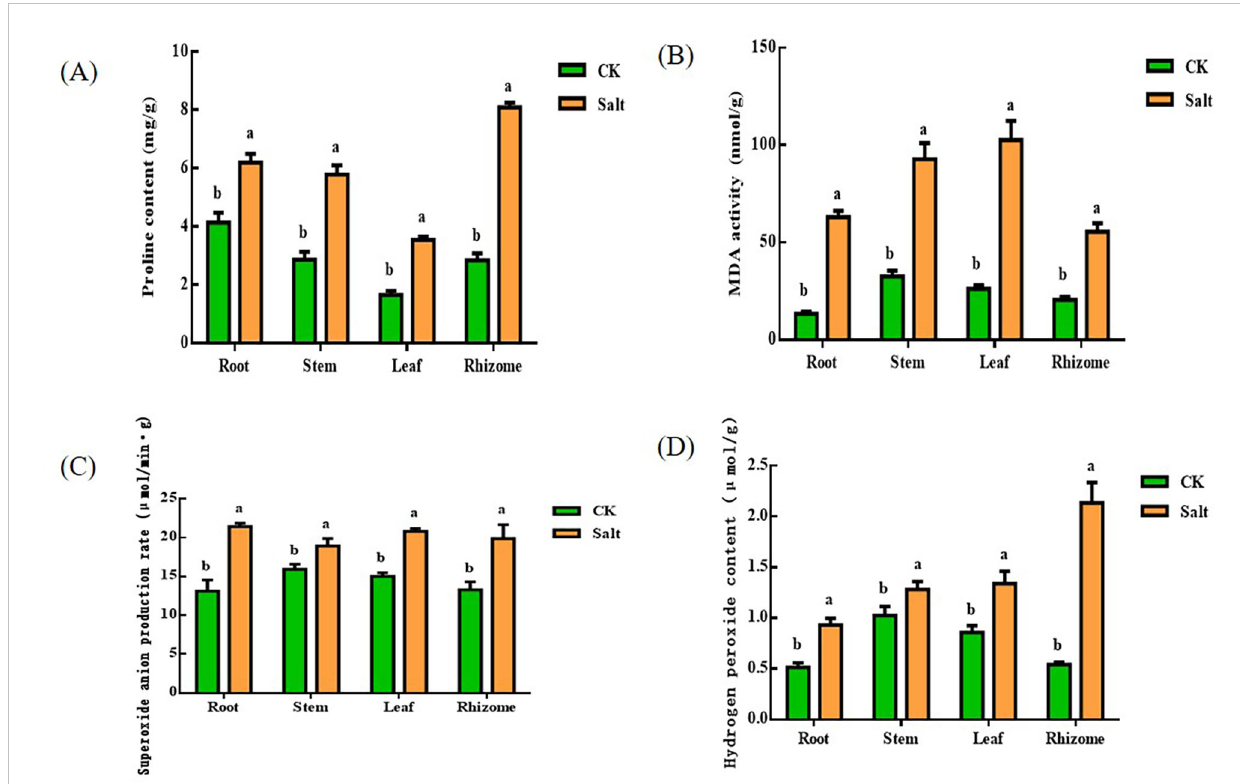
FIGURE 3 Effects of salt stress on proline, malondialdehyde, superoxide anion production rate and hydrogen peroxide content in different parts of ginger seedlings. (A) The proline content. (B) The malondialdehyde content. (C) The rate of superoxide anion production. (D) The hydrogen peroxide content. The lowercase letters a and b mean the letter markers for signi fi cant difference